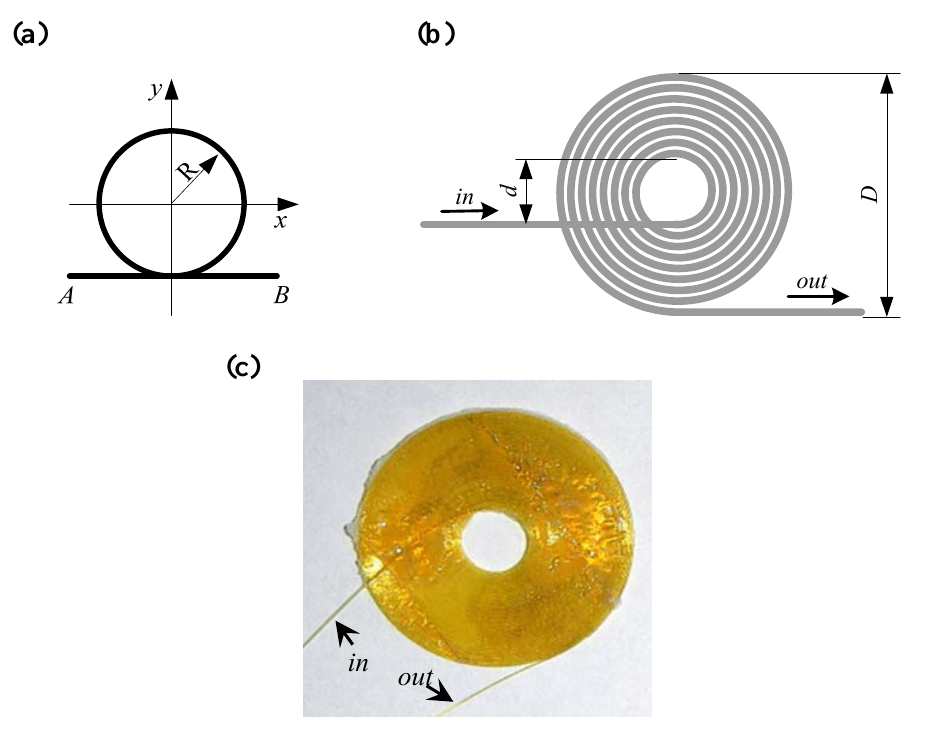
Figure 3. (a) Sketch of circular loop FOD sensor. (b) Sketch of spiral FOD sensor. (c) Picture of the spiral FOD sensor with outer diameter 21.2